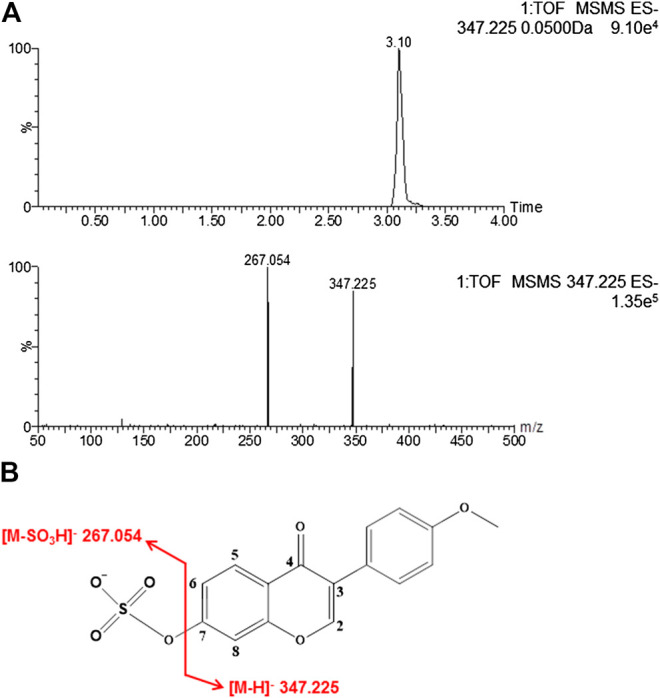
The chromatogram of formononetin sulfate under MS/MS scanning (A) and the fragmentation pathways of formononetin sulfate (B).